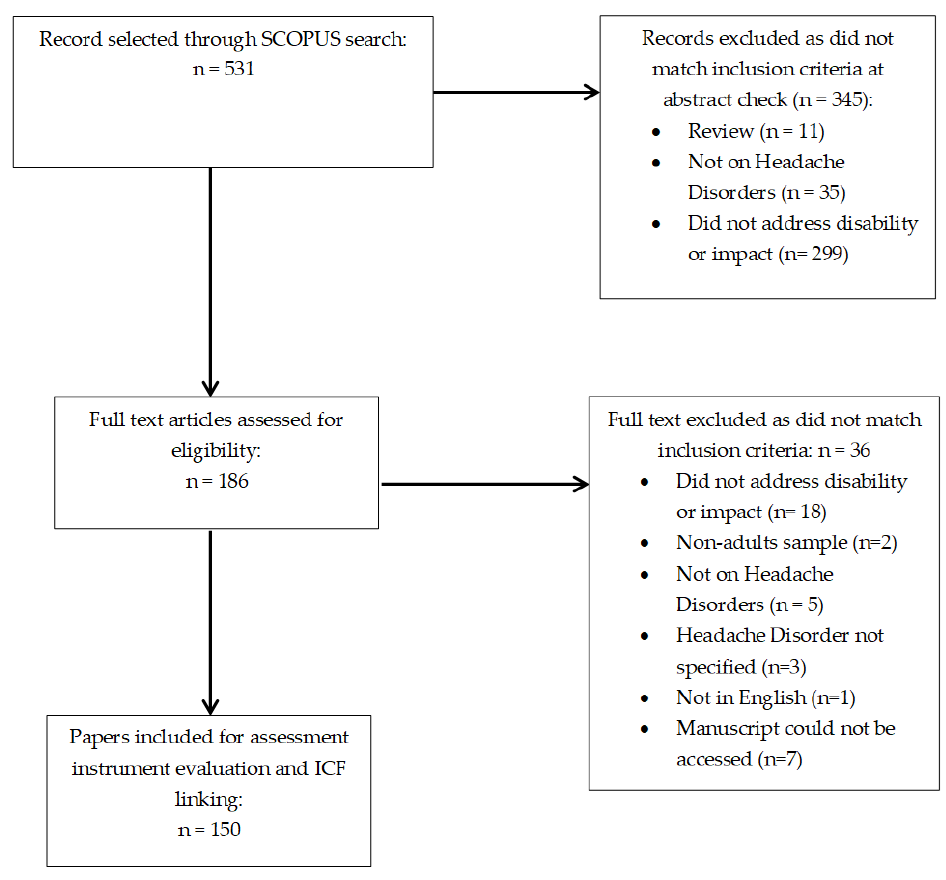
Figure 1. Flow-chart of selected studies.